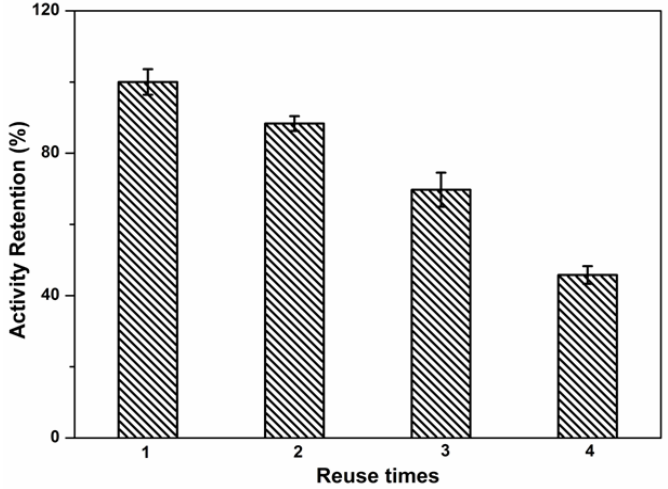
Figure 9. Reuse stability of immobilized